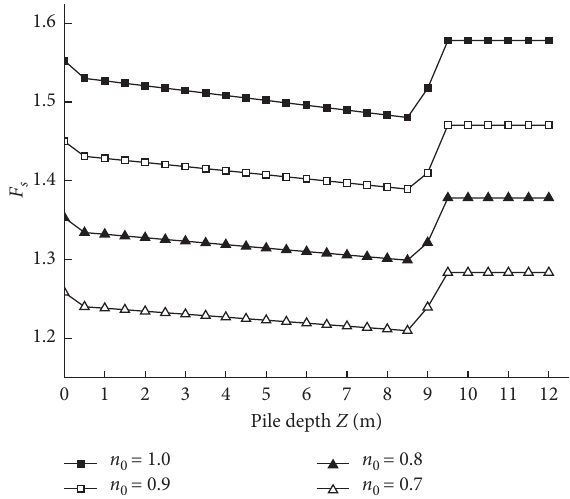
Figure 5: Effects of the nonhomogeneous coefficient on the sta- bility of 3D slopes.